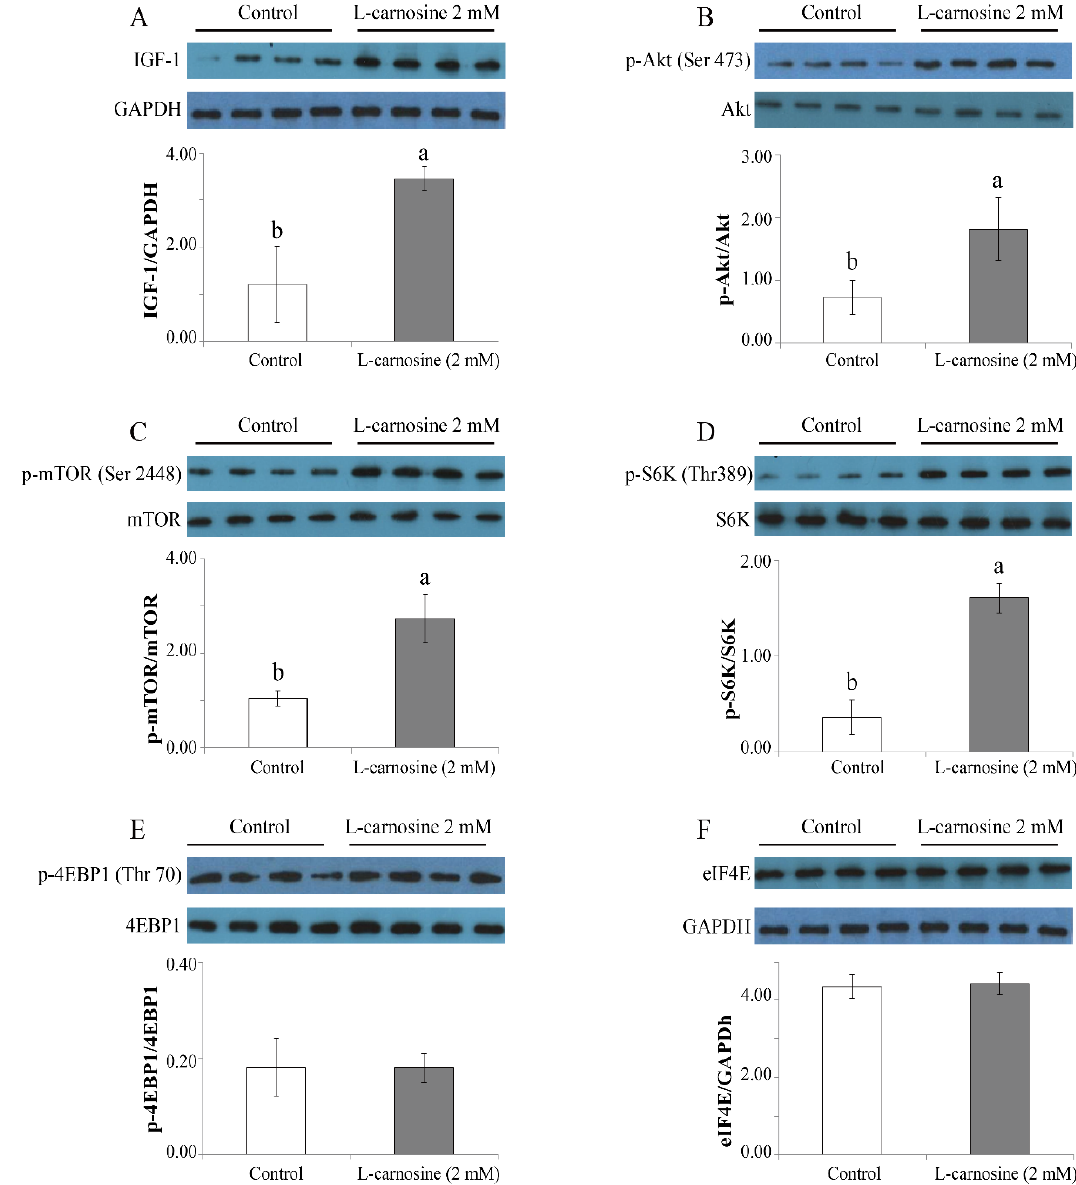
Figure 5. Effect of carnosine on expression of mTOR pathway in satellite cell cultures ( n = 4). Values of IGF-1 ( A ) and eIF4E ( F ) are presented in relation to the GAPDH concentration, while the values of Akt ( B ), mTOR ( C ), S6K ( D ), and 4EBP1 ( E ) are presented as phosphorylation concentrations in relation to the total concentration. Control, growth medium without L-carnosine; L-carnosine 2 mM, growth medium received 2 mM L-carnosine. p-, phosphorylation; Ser, serine; Thr, threonine; IGF-1, insulin-like growth factor-1; Akt, protein kinase B; mTOR, mechanistic target of rapamycin; S6K, ribosomal protein S6 kinase; 4EBP1, 4E binding protein 1; eIF4E, eukaryotic initiation factor-4. The data were expressed as mean ± SD. Means with different letters (a, b) indicate significant difference at p <